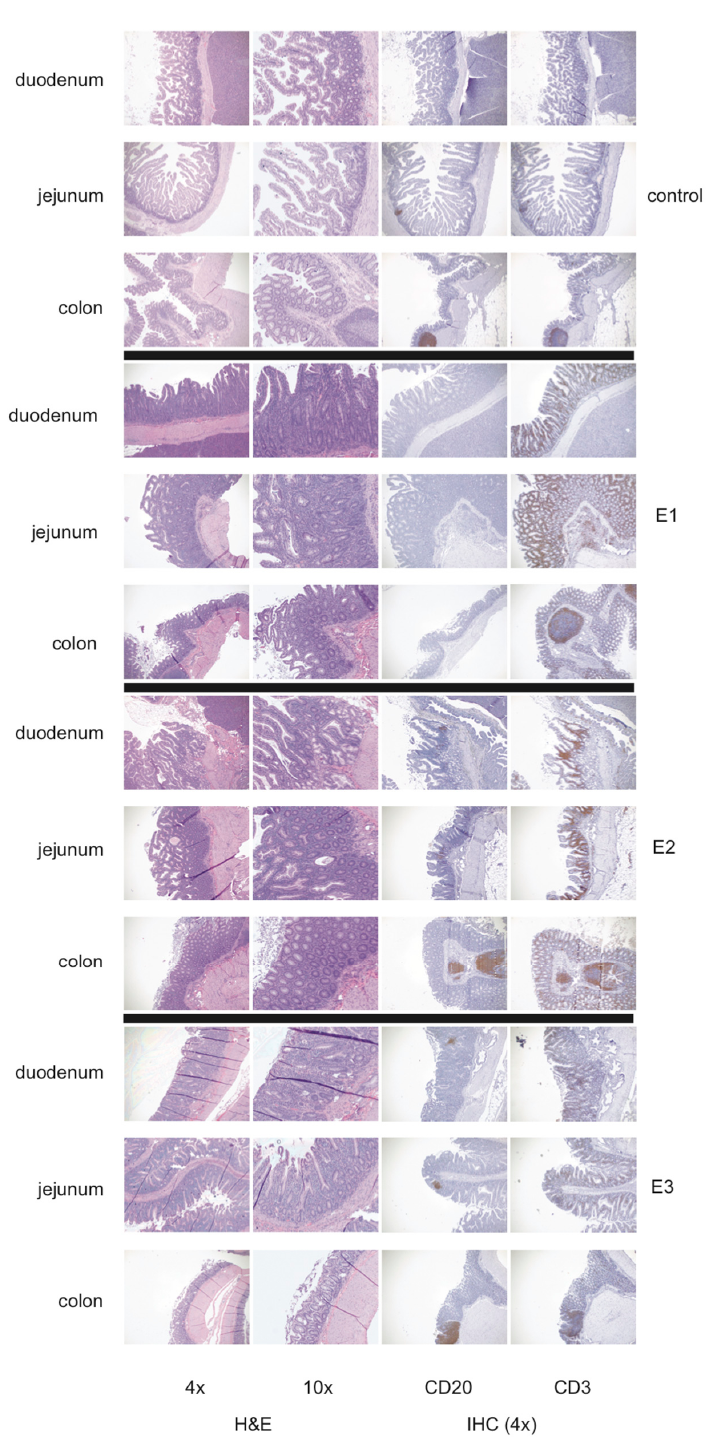
Figure 5. Representative photomicrographs show disruption of the normal architecture in the duodenum, jejunum, and colon by lymphocytic enterocolitis in common marmosets. Histology was performed upon intestinal samples from 85 common marmosets. Intestinal sections were stained with hematoxylin and eosin (H&E) and with B cell-specific and T cell-specific staining procedures (immunohistochemistry) with monoclonal antibodies to CD20 or CD79 (B cell markers) and CD3 (T cell marker), respectively. E1, E2, and E3 represent three different marmosets with lymphocytic enterocolitis. E1 has disease in the duodenum and jejunum that spares the colon, while E2 and E3 have disease in the duodenum, jejunum, and colon.